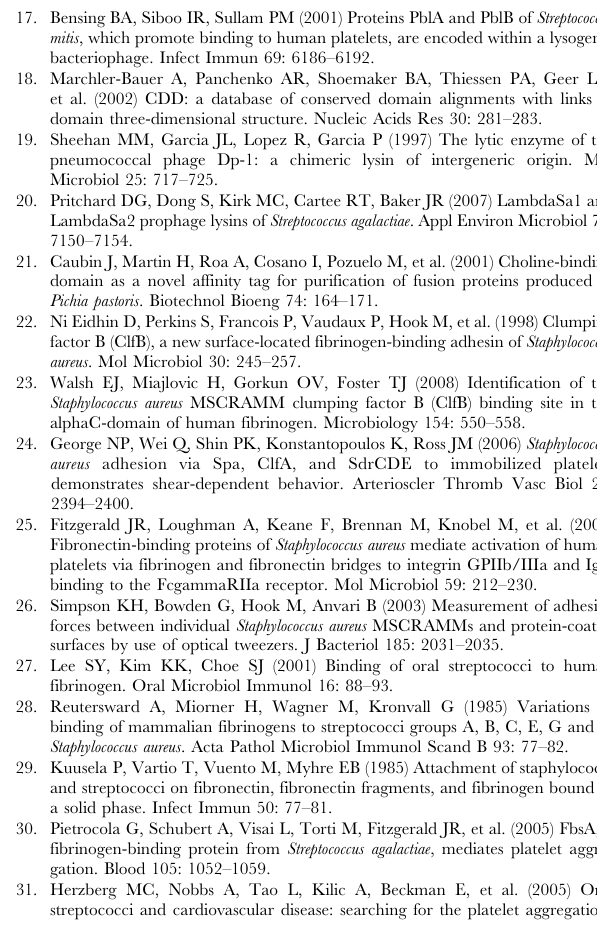
FLAG lysin SM1 . Binding was assessed as described for human fibrinogen in the [Methods] section. Values shown are the means ( 6 S.D.) of triplicate data from a representative experiment. Figure S4 Impact of lysin SM1 expression on virulence. Endo- carditis was produced in rats, using an inoculum containing SF100 and PS344, SF100 and PS1006, or PS344 and PS1006 at a 1:1 ratio. 72 h post infection, the animals were sacrificed, and log 10 CFU/g of tissue (vegetation, kidney, and spleen) for each strain was determined by plating onto selective media. In vivo competition index (CI) was calculated for each pair of organisms as described in the [Methods]. Circles represent data from individual animals. A CI below 10 0 indicates a competitive disadvantage for A) PS344 versus PS344, B) PS1006 versus SF100, or C) PS1006 versus PS344.